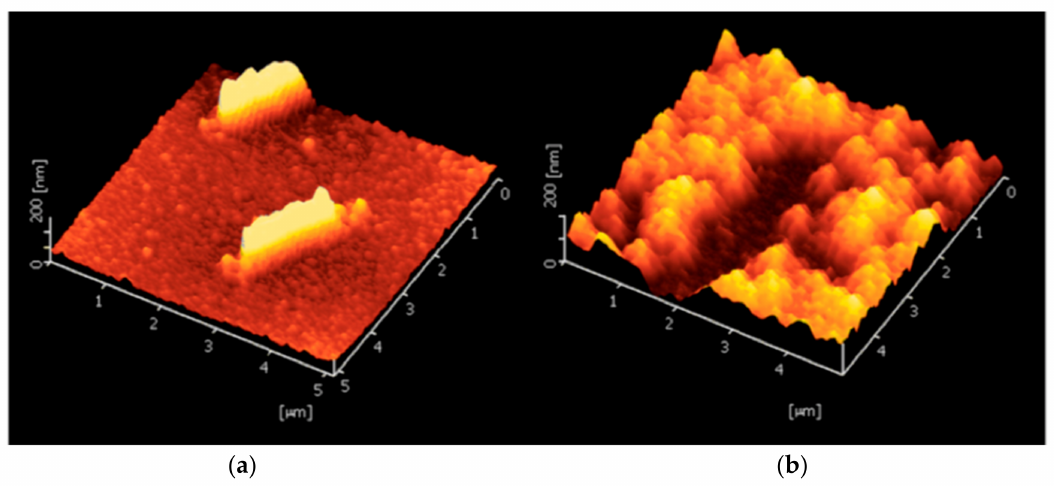
Figure 22. AFM image of bacteria imprinted polymer, before ( a ) and after ( b ) washing. Reproduced with permission of Elsevier from